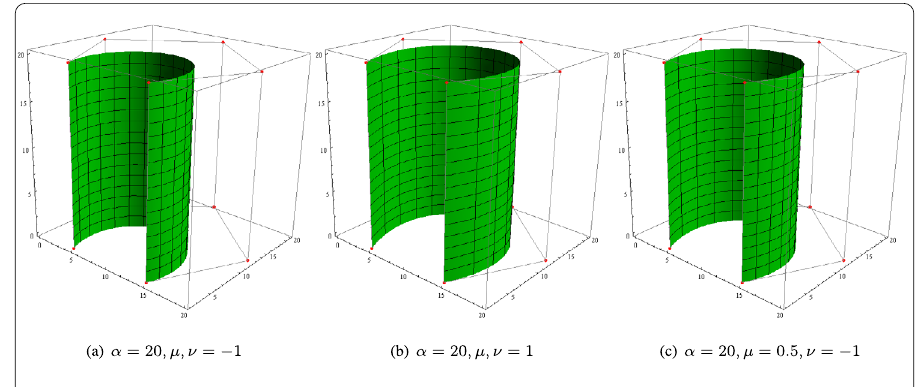
Figure 4 GBT-Bézier cylinders with different shape